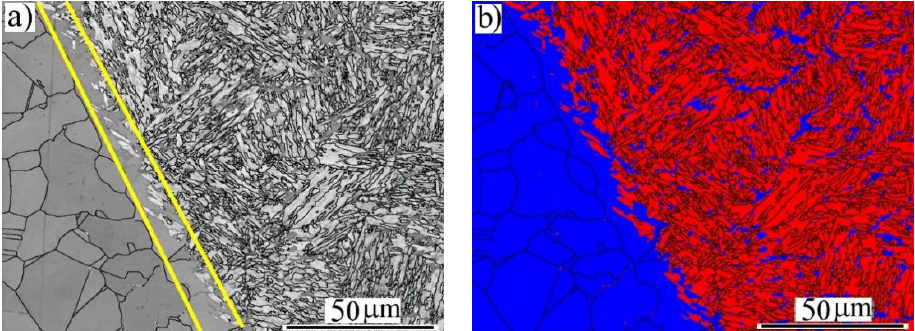
Figure 8. EBSD imaging maps of the fusion zone (FZ) near the fusion boundary (FB) of the BM-ASS at an EI of 320 J/mm: ( a ) image quality (IQ) map; ( b ) phase map of α (cid:48) - bct in red and γ - fcc austenite in blue.